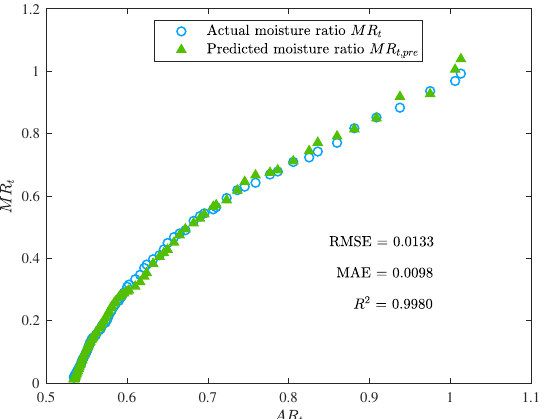
Figure 10. The prediction performance of the ANN model (the moisture ratio predicted by the ANN model MR t , pre vs. the area ratio AR t ).